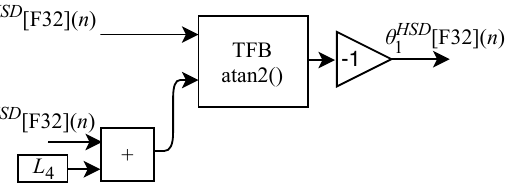
[ F 32 ]( n ) angular position 1